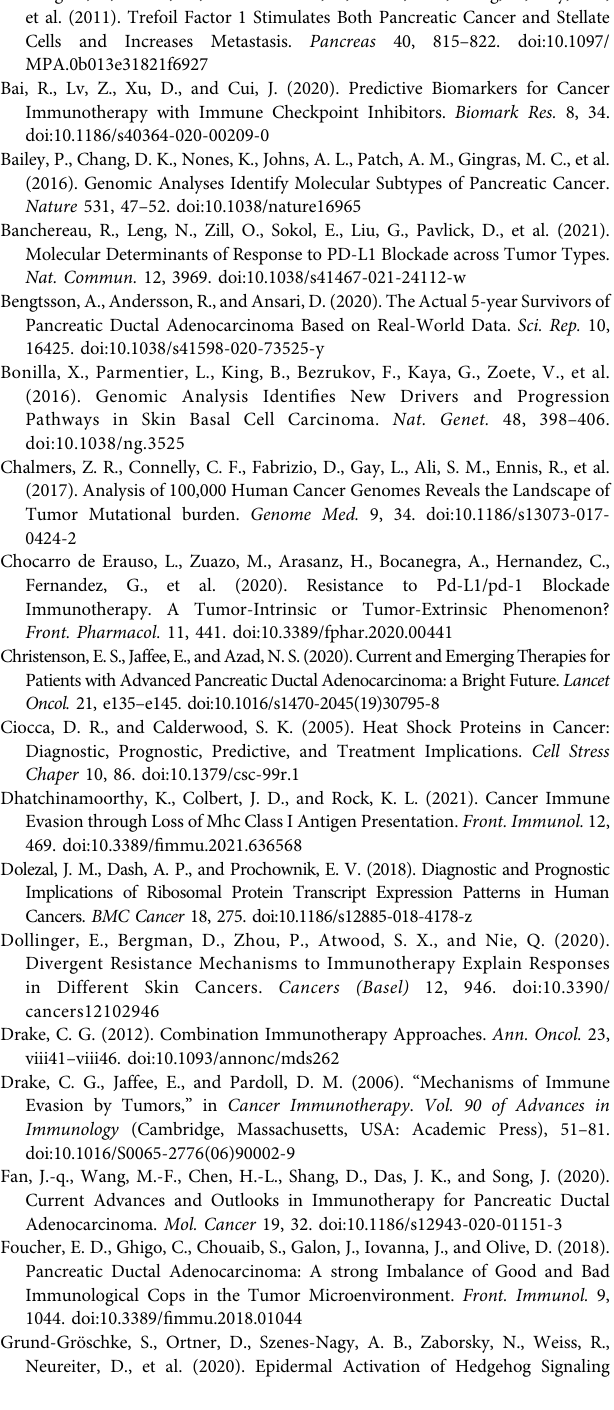
proportion of top n highly variable genes that are common between BCC and melanoma CD8+ T cells. (D) Fold change differential expression of MHC and HSP genes between BCC and melanoma CD8+ T cells; positive values indicate greater expression in